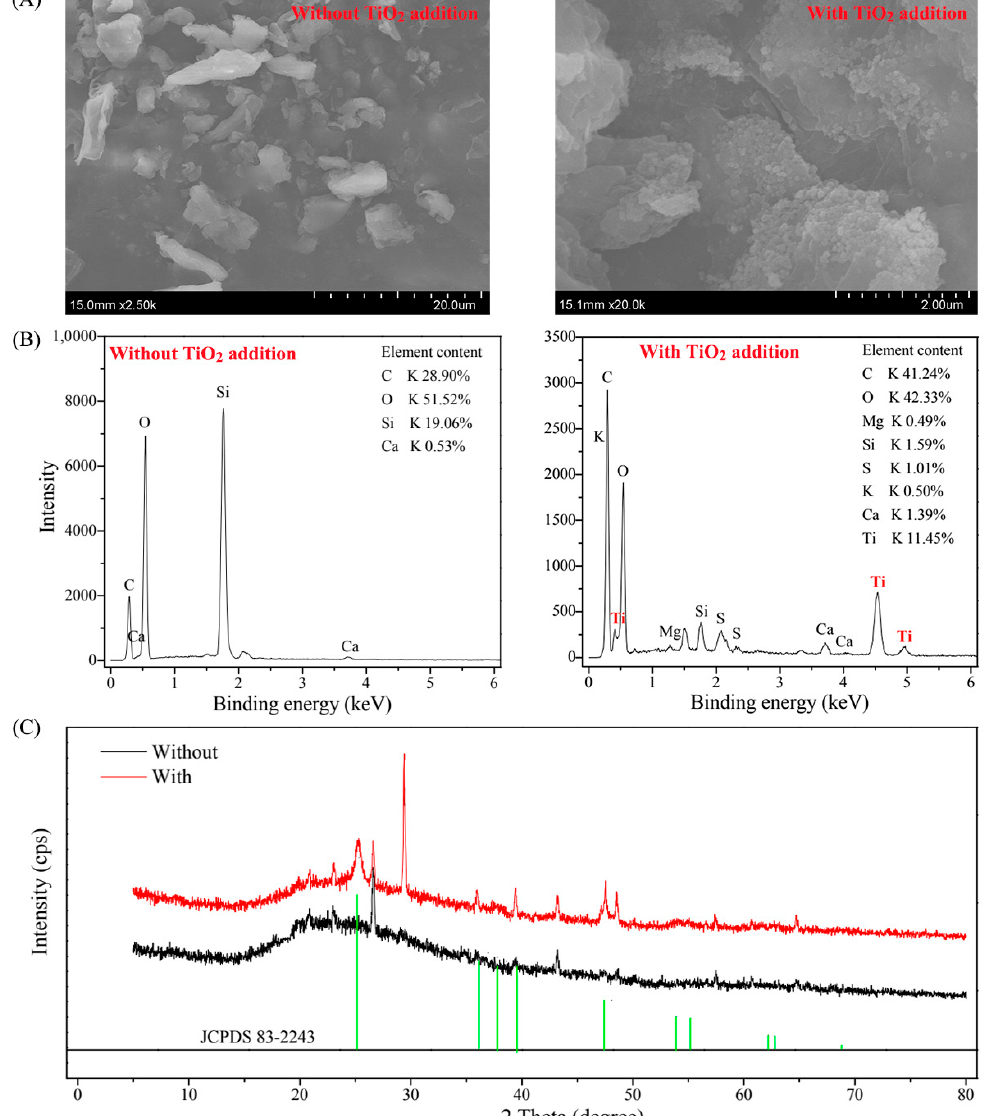
Figure 3. Characterization of the cell surface and TiO 2 by using scanning electron microscopy ( A ), energy dispersive spectroscopy ( B ), and X-ray diffraction ( C ).